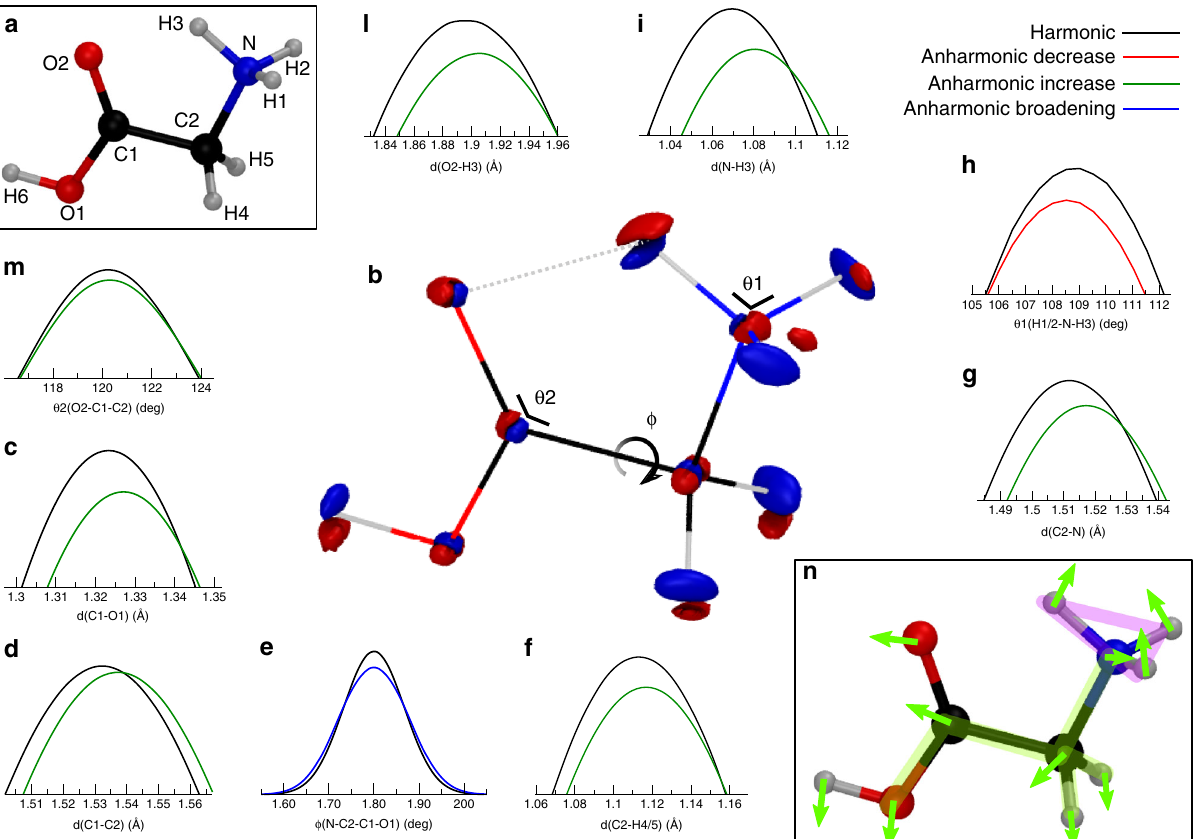
Fig. 2 Comparison of harmonic and anharmonic nuclear densities for the vibrational ground state. a The C s symmetry equilibrium geometry of GlyH + at DFT-B3LYP/aug-cc-pVDZ level of theory with the atomic labeling that we adopt as reference throughout the paper. b Two isosurfaces of the difference between the anharmonic and the corresponding harmonic nuclear densities for the vibrational ground state. Red indicates positive contributions, where the density concentrates due to anharmonicity, while blue stands for the negative contributions, where the density is depleted. The density isosurfaces are respectively set to 0.15a.u. and − 0.15a.u. In addition, we report the comparison of the maxima of relevant geometry parameter distributions. c , d , f , g , i , l Bond lengths distributions. h , m bond angles distributions. e Dihedral distribution. The black curves are obtained from the harmonic approximation while the colored ones are calculated from the full anharmonic wavefunction. Green curves present the maximum shifted towards longer bond lengths or wider angles (Anharmonic increase), on the contrary red indicates contraction (Anharmonic decrease). Blue stands for broadening of the anharmonic distribution with respect to the harmonic one, without maximum shift (Anharmonic broadening). n Pictorial representation of the overall effect of anharmonicity and couplings on the quantum nuclear density which leads to speci fi c nuclear density redistribution (indicated by the green arrows) giving two distinctive structural effects, the backbone elongation (highlighted in green) and the closing of NH þ umbrella (highlighted in magenta). These are deduced from the consideration of 3 geometrical parameters distributions reported in c – i , m and in the Supplementary Figs. 1, 2,